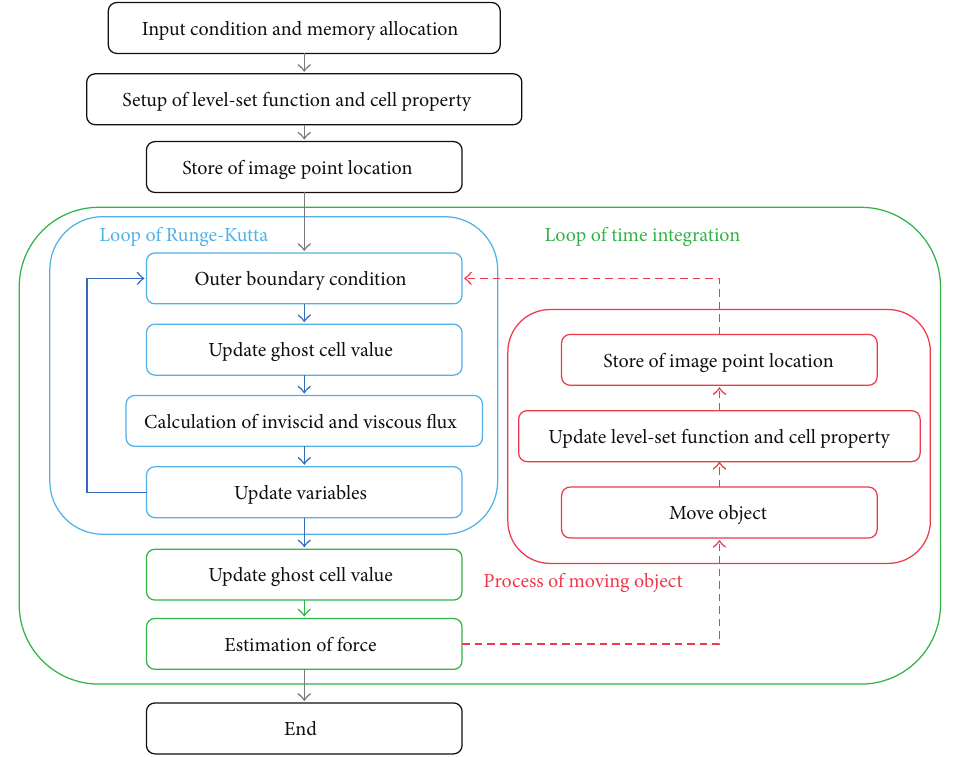
Figure 5: Flowchart of the present numerical